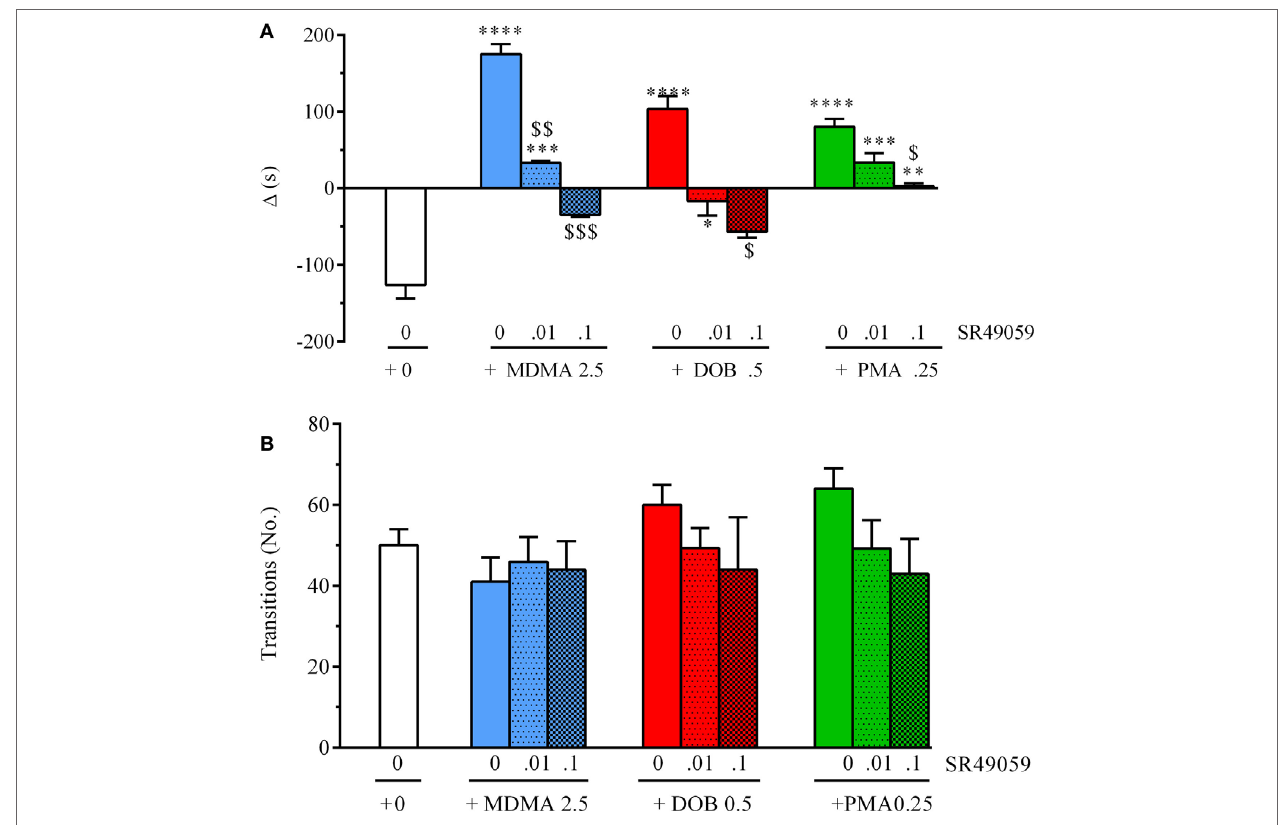
FigUre 6 | SR49050 dose-dependently blocks the anxiolytic effect induced by 3,4-methylenedioxymethamphetamine (MDMA), 2,5-dimethoxy-4-bromo- amphetamine hydrobromide (DOB), and para -methoxyamphetamine (PMA) in the light dark test. Mean values ± SEM of the differences ( Δ ) in the time spent in the light and dark compartments (a) and the number of transitions between them (B) during the 5-min sessions. The combination of SR49059 (ng/kg) or vehicle and each drug (mg/kg) was given intramuscularly (IM) immediately before each test. n = 10 fish per group. * p < 0.05, ** p < 0.01, *** p < 0.001, **** p < 0.0001 vs. the corresponding saline group (0 + 0); $ p < 0.05, $$ p < 0.01, $$$ p < 0.001 vs. the corresponding drug alone (Tukey’s test).